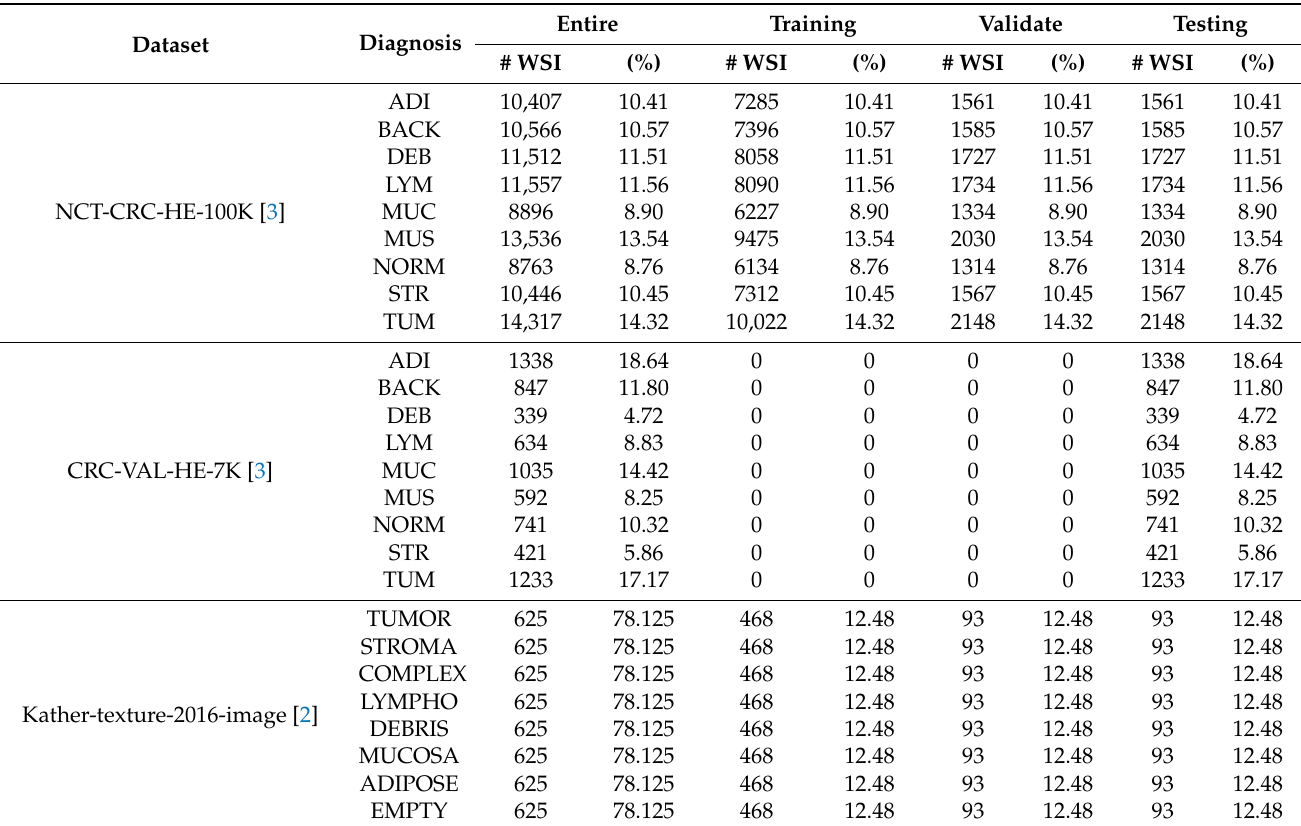
Table 2. CRC dataset of histological